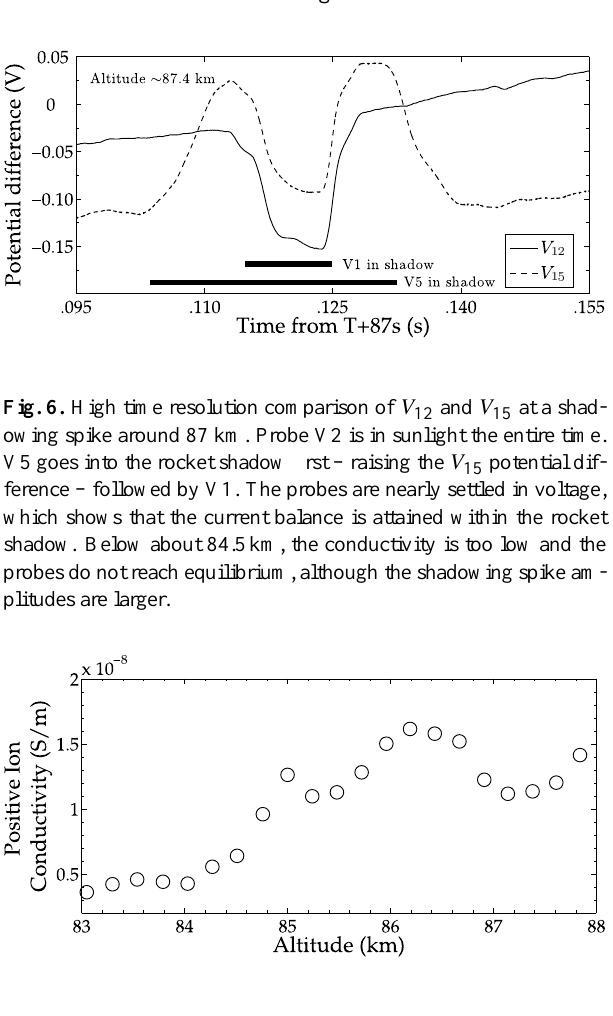
Fig. 7. Positive ion conductivity calculated from the shadowing spike amplitudes and aerosol densities. Points below about 84.5km over-estimate the conductivity, since the shadowing spikes do not quite reach equilibrium within the rocket shadow. If there were other significant return currents present, they would inflate the cal- culated conductivity values. As such, this reflects the maximum value one could expect the ion conductivity to have.